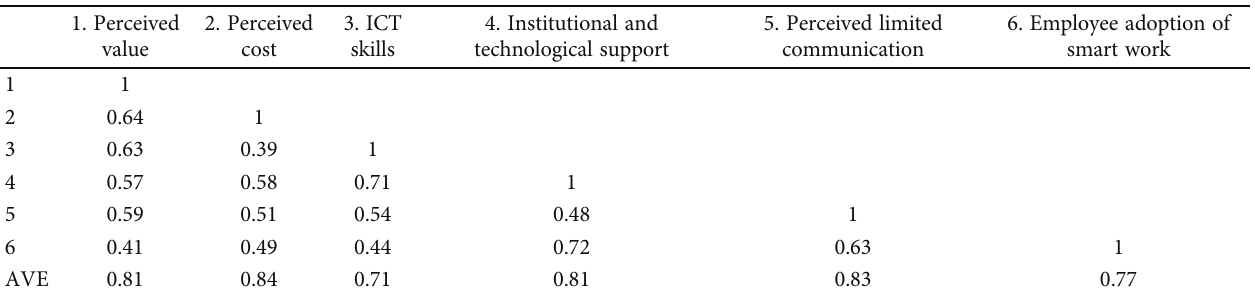
Table 4: Intercorrelation matrix.